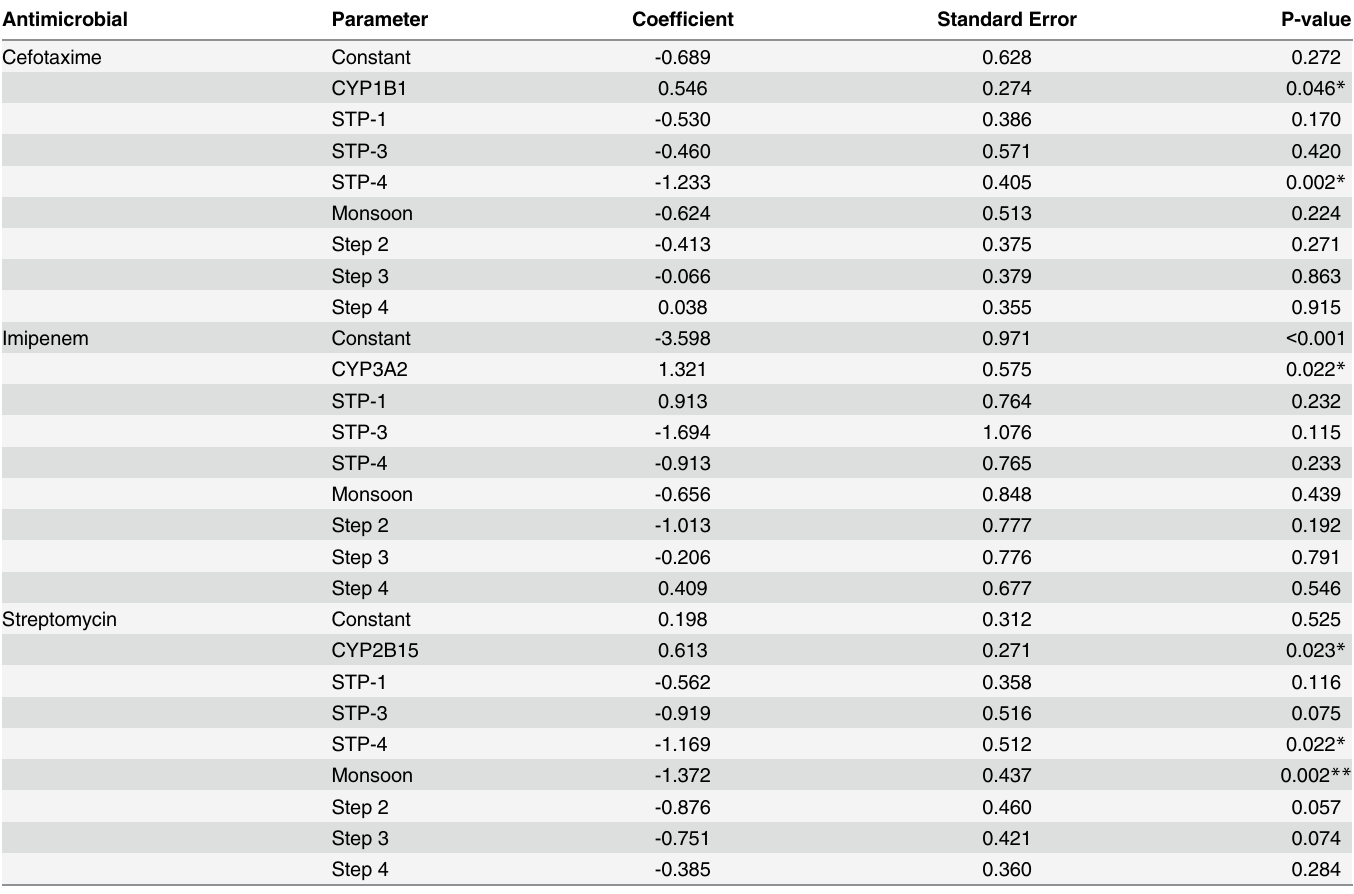
1 Data shows if only signi fi cant association between an antimicrobial agent and gene expression was found. All other data are given in S2 Table. STP-2, pre-monsoon and Step 1, were assigned as the reference level for the variables of the sewage treatment facility, season and processing step, respectively. The asterisks shown to the P values shows the levels of statistical signi fi cance ( * < 0.05, ** <